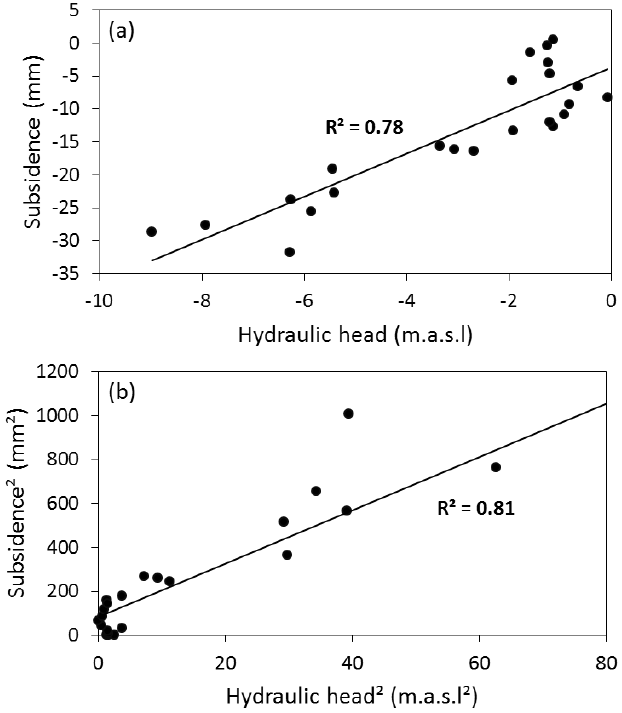
Figure 6. Relationship between the target variable and the explanatory variable for the two best linear regression models (S = a × P + b; S² = a × P² + b) for Piezometer 3.